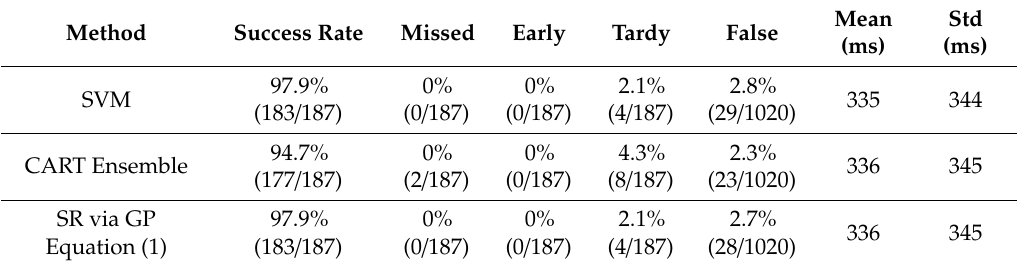
Table 1. The figures of merit obtained using SVM (threshold probability 80%) and Equation (1) for campaigns